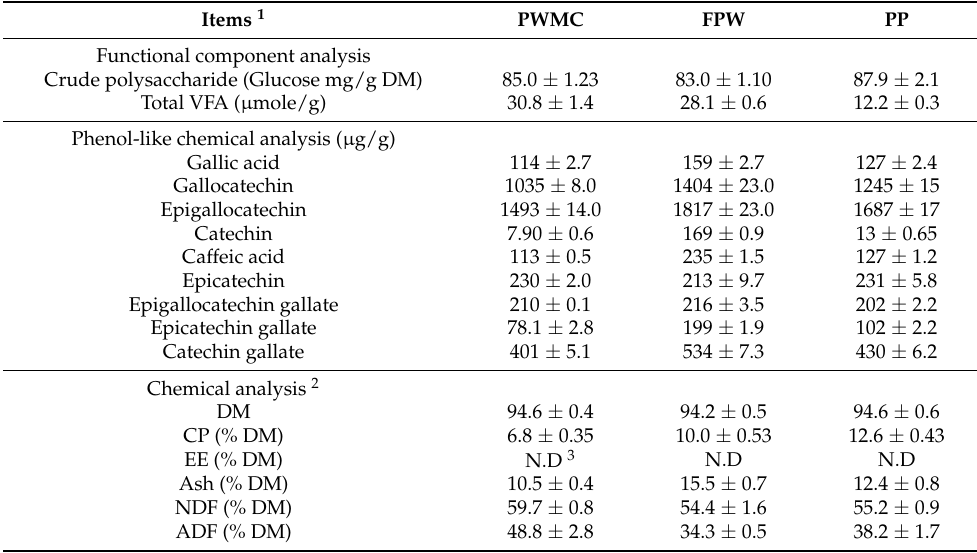
Table 3. The functional chemical composition analysis of Pennisetum purpureum Schum No.2 waste mushroom compost, Saccharomyces cerevisiae fermented PWMC, and Pennisetum purpureum Schum No.2.